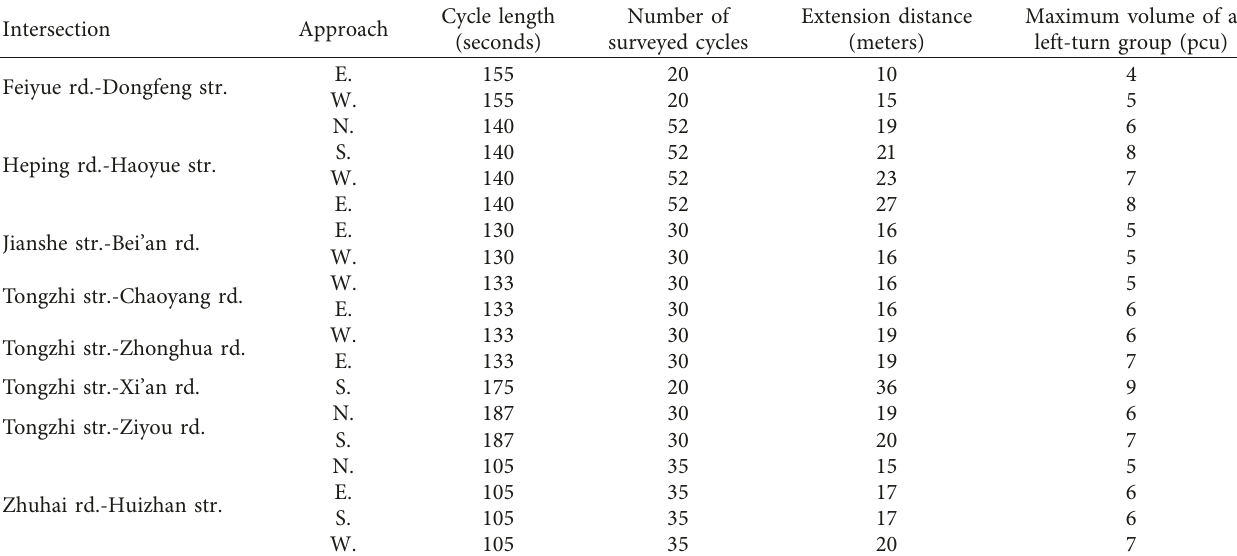
Figure 1: The definition of a left-turn Table 1: Description of field sites.